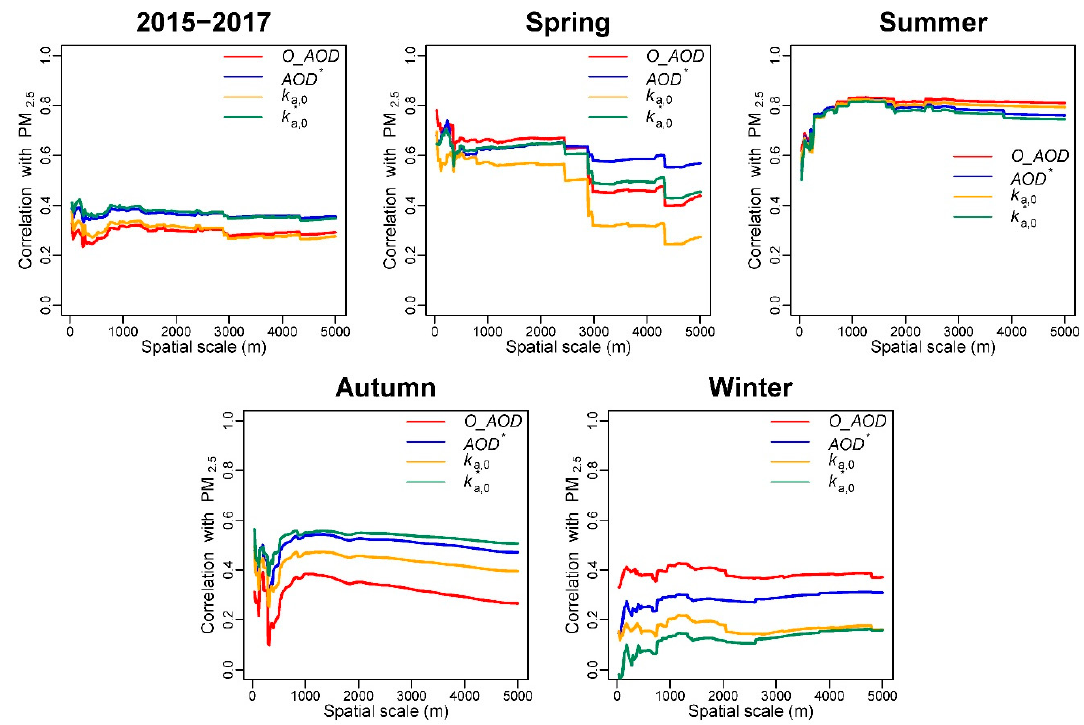
Figure 4. Impact of spatial scales on annual and seasonal correlations between PM 2.5 concentrations and GF-1 uncorrected aerosol optical depth ( O_AOD ), humidity-corrected AOD ( AOD* ), uncorrected and humidity-corrected near-surface extinction coe ffi cients ( k a ,0 , and k ∗ ) in Shenzhen City, China from 2015 to 2017.